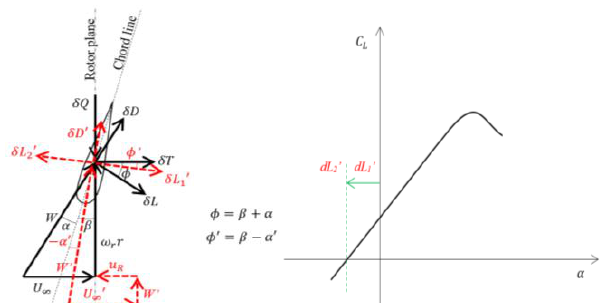
Fig. 17. 2-dimensional sketch (left) of a blade cross-section. Typical lift coefficient over angle of attack curve